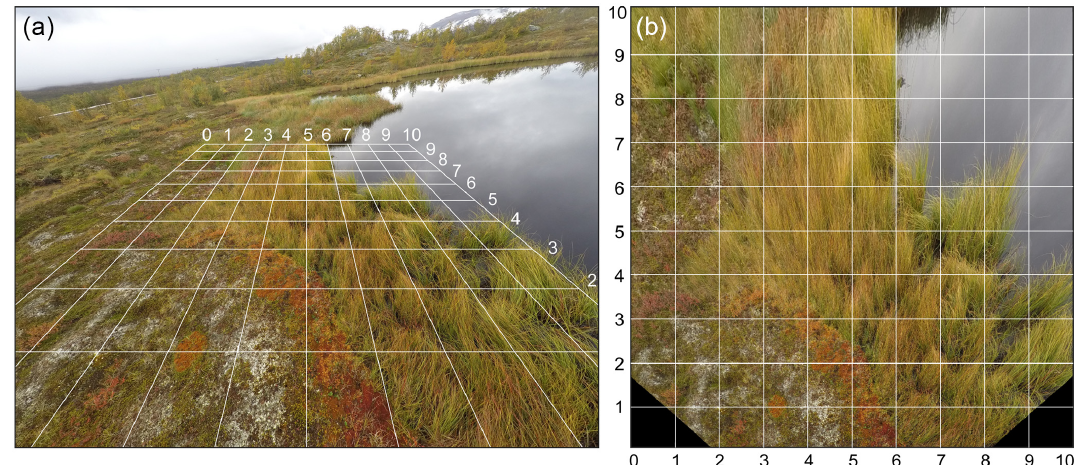
Figure 6. One of our field plots. (a) Image corrected for lens distortion, with a projected 10 × 10m grid overlaid. (b) Image after recalculation to overhead projection (10 ×